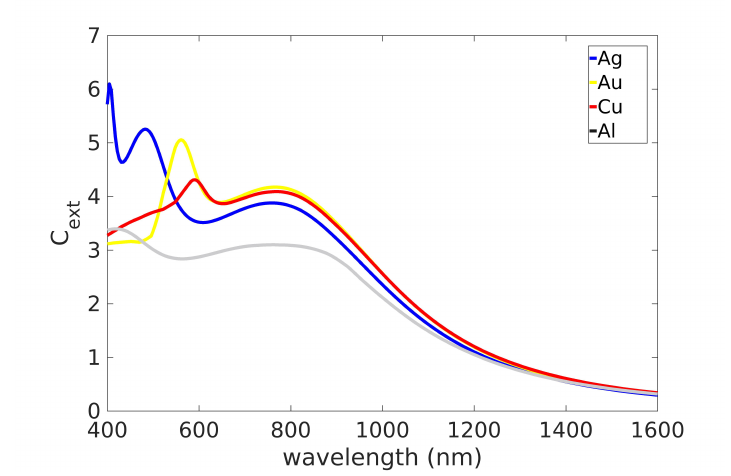
Figure 3. Extinction efficiency for Ag, Au, Al and Cu particles with radius a = 100 nm embedded in water ( (cid:101) h = 1.77) calculated according Mie